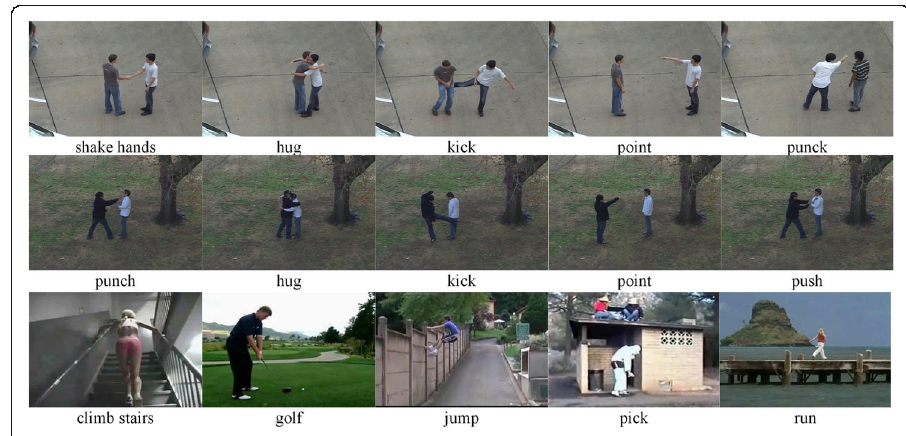
Fig. 6 Some sampled frames from UT-Interaction and